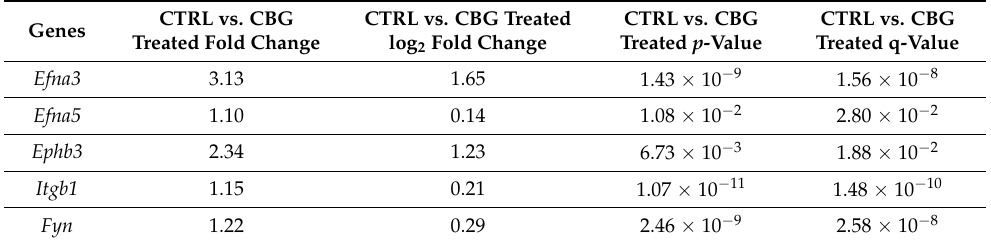
Table 3. Differentially expressed genes involved in Ephrin-Eph